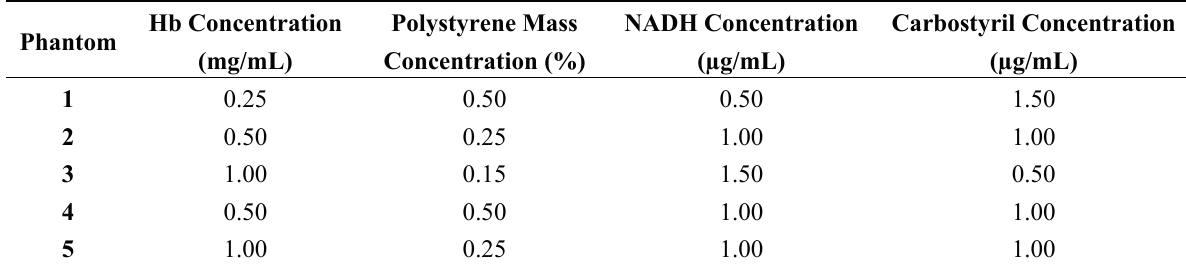
Table 1. Phantoms used for the validation and analysis of spectroscopic signals.